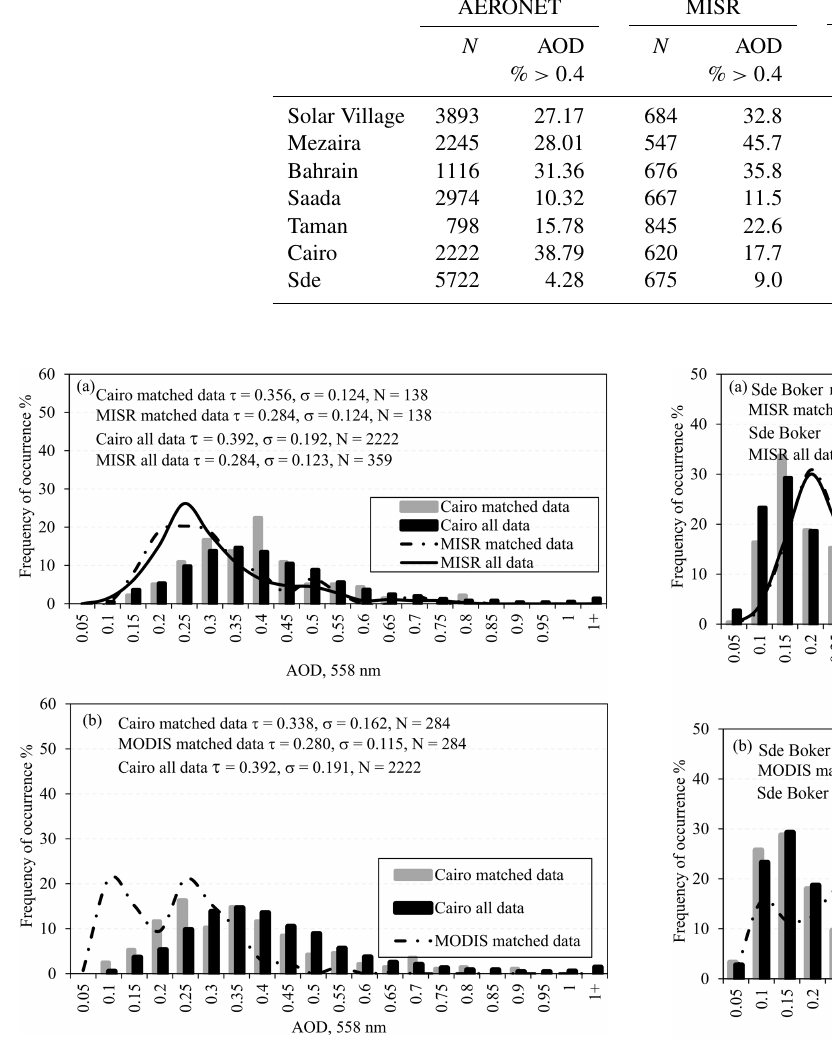
Figure 11. Histogram of the MISR, MODIS, and Sde Boker AERONET measurements (a) MISR and (b) MODIS data re- trievals.